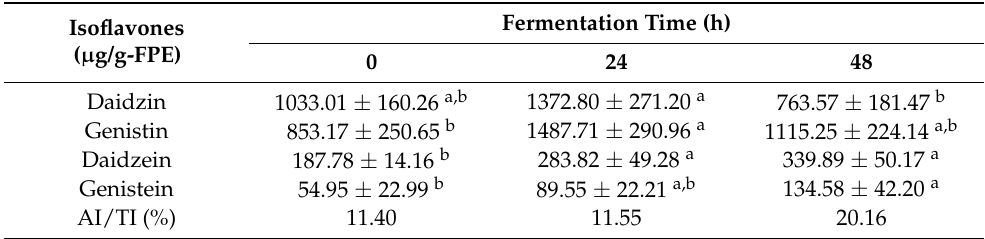
Table 2. Effect of Elaeocarpus serratus L. leaves on the biotransformation of isoflavones with L. plantarum BCRC 10357 1